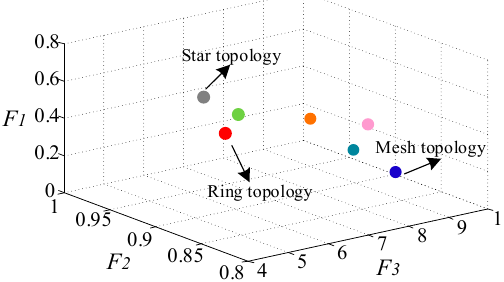
Figure 6. Pareto frontier of the multi-objective optimization model.